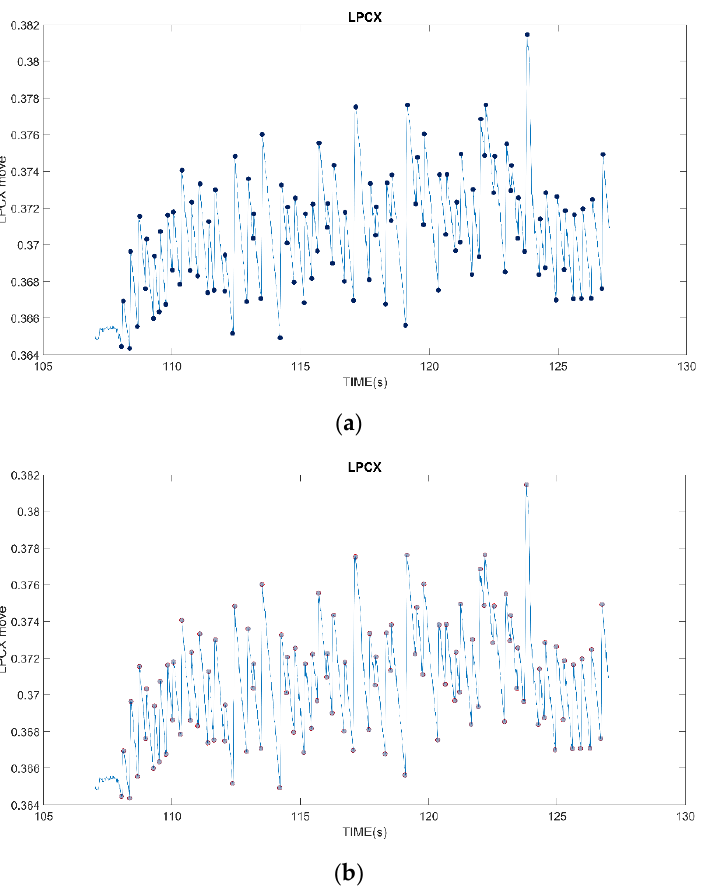
Figure 7. Results of proposed method. ( a ) Results marked by physicians; ( b ) The results of this method were compared with those marked by physicians.